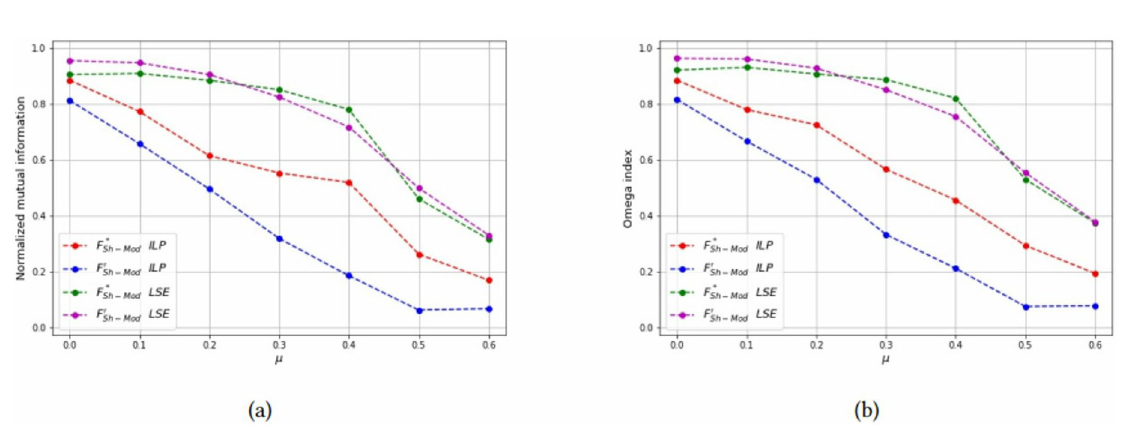
Fig 16. Test results on overlapping communities, parameters p = 2, μ o = 0.5, N o = 3. (a) Average NMI for each solution method, (b) Average Omega for each solution method.